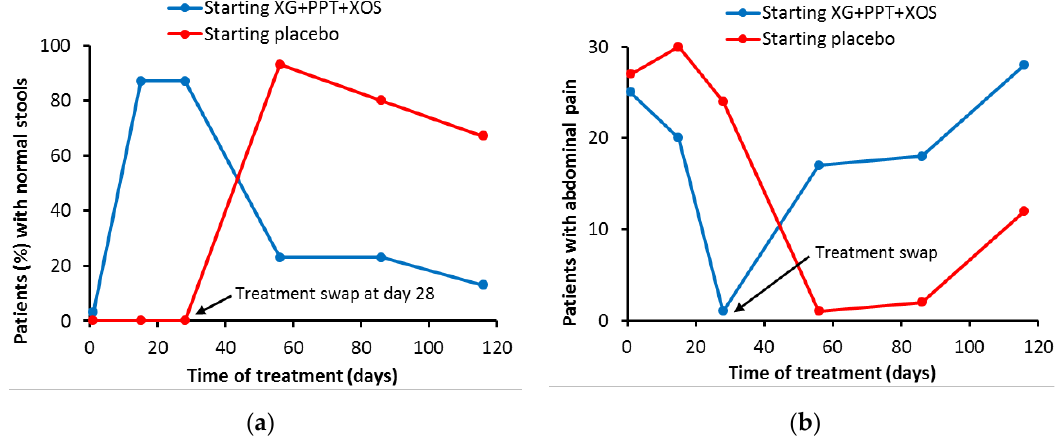
Figure 8. Evolution of ( a ) the percentage of patients who evacuated normal stools (3-4 on the Bristol scale) and ( b ) the number of patients who reported abdominal pain, as a function of time. The mucosal protectant (formulation with XG, pea proteins and tannins (PPT), and xylo-oligosaccharides (XOS)) was compared to a placebo. In both cases, the treatment was administered for 28 days. Afterward, the treatments were exchanged and patients received the other product for another period of 28 days. Treatments were stopped on Day 56, and patients were followed for an additional 60 days until Day 116. (Adapted from Trifan et al., 2019, [109], with permission from SAGE Publishing.)